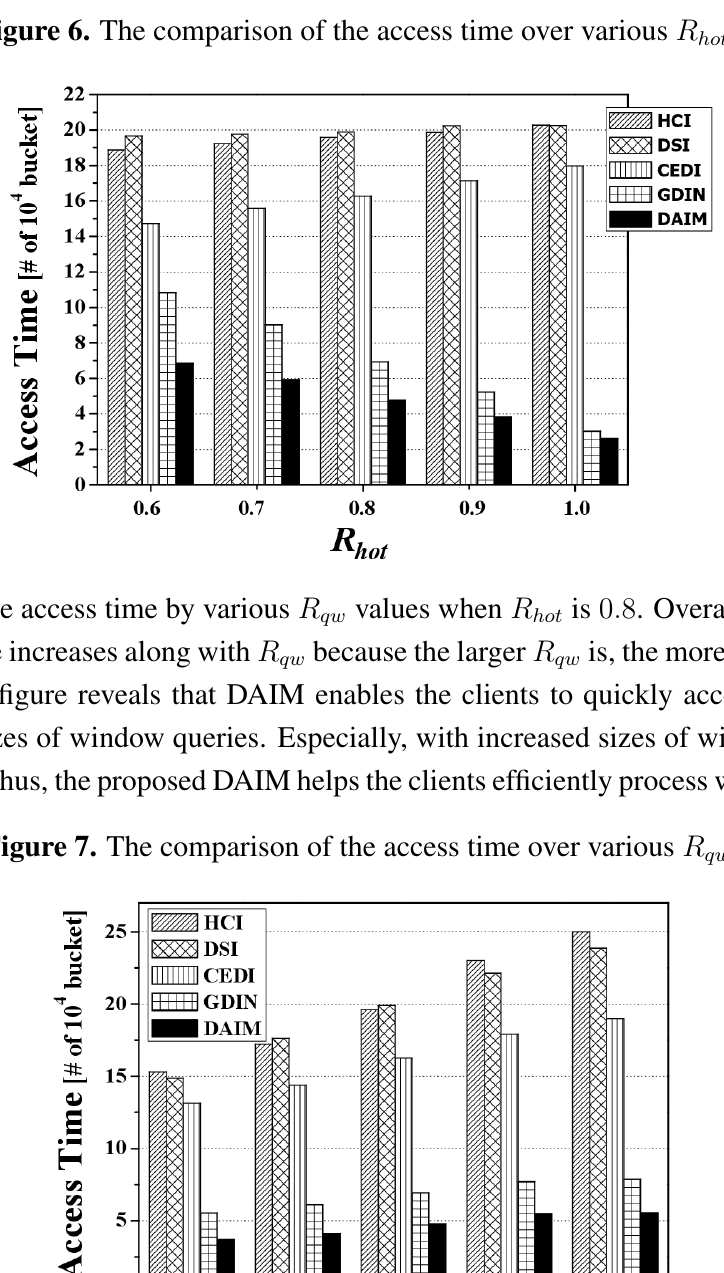
Figure 6. The comparison of the access time over various R